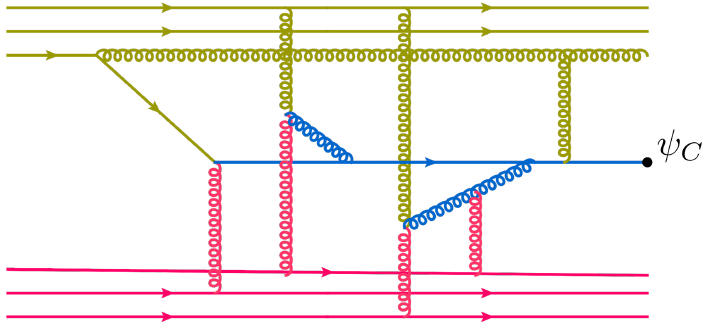
Figure 3 . Typical diagram for the classical field with projectile/target sources. The Green functions of central fields are given by retarded